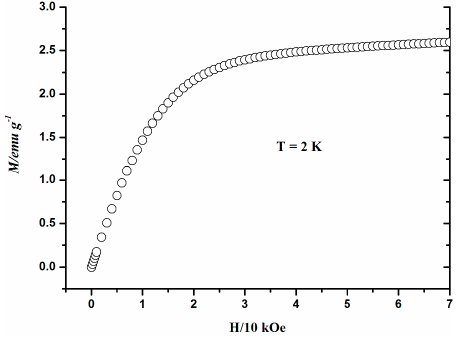
Figure 8. Plot of magnetization for the complex 1 at 2 K.